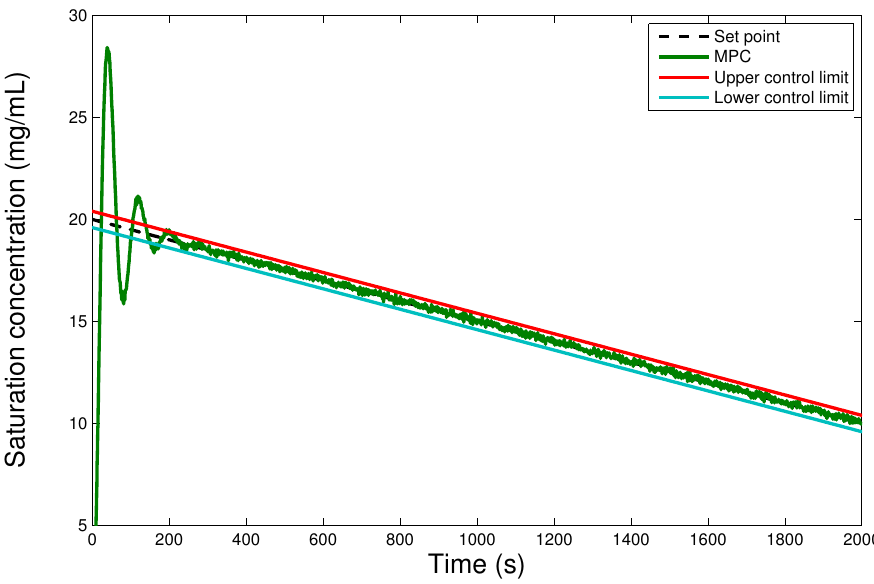
Figure 3. Hybrid MPC-PID performance of the saturation